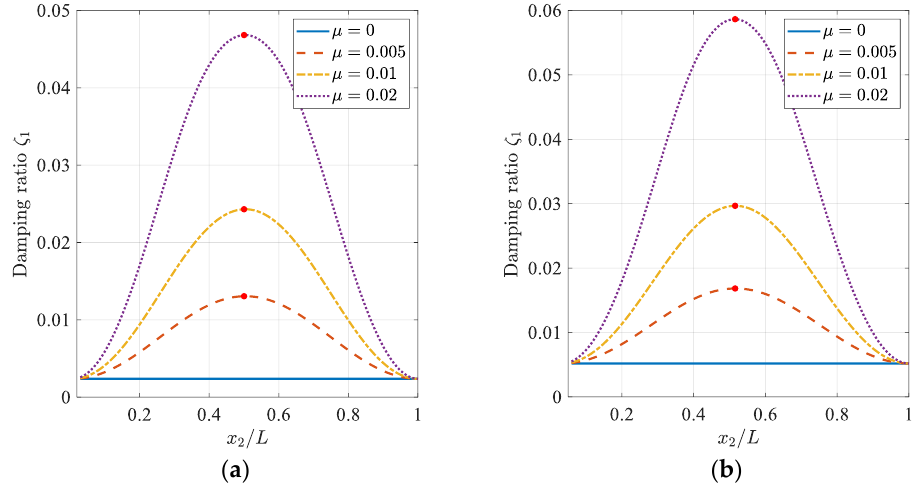
Figure 8. First modal damping of a cable with two dampers versus the TM-HDR-D location x 2 / L ( ϕ = 0.5, ρ = 1), with ( a ) x 1 / L = 0.02 and ( b ) x 1 / L = 0.05.